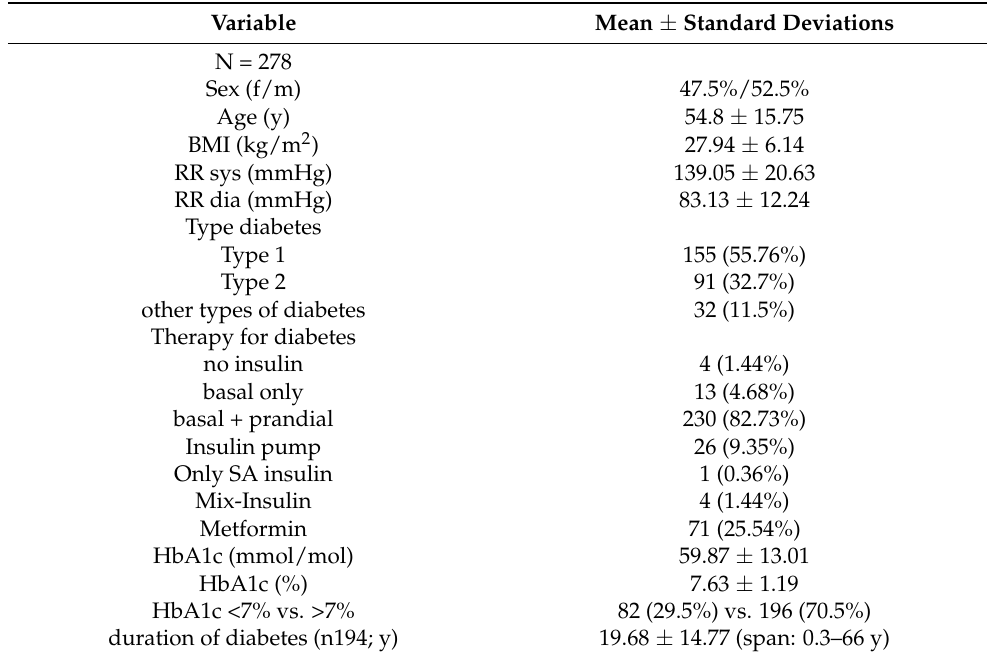
Table 1. Baseline characteristics (SA: short